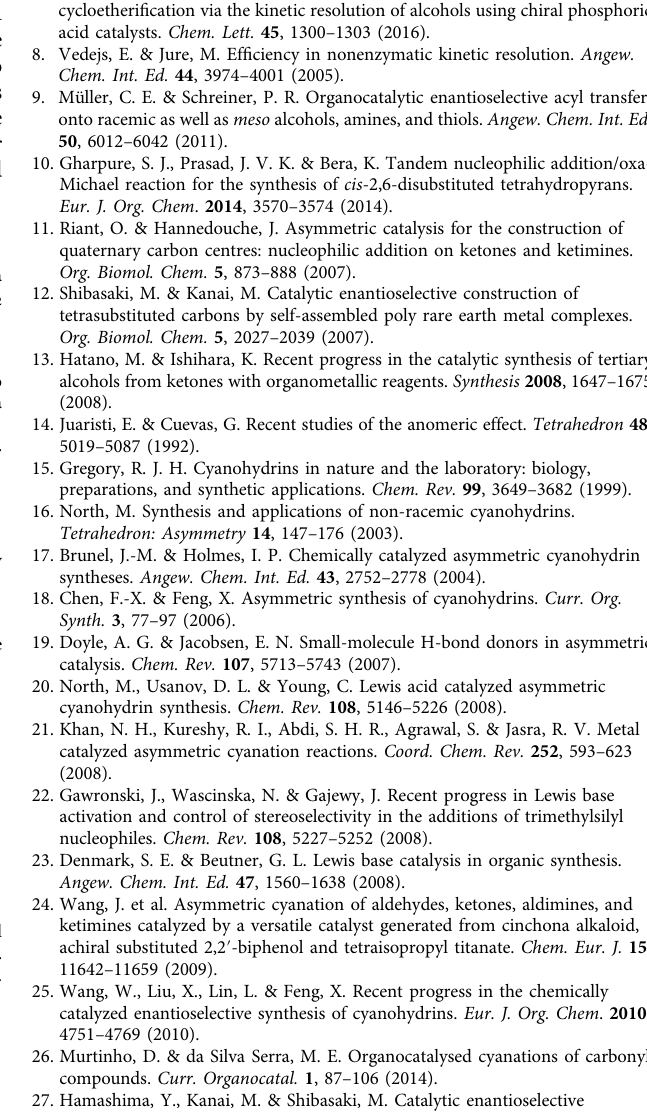
Fig. 122. X-ray crystallographic data have also been deposited at the Cambridge Crystallographic Data Centre (http://www.ccdc.cam.ac.uk/) with the accession code CCDC 1566029. All other data are available from the authors upon reasonable request.